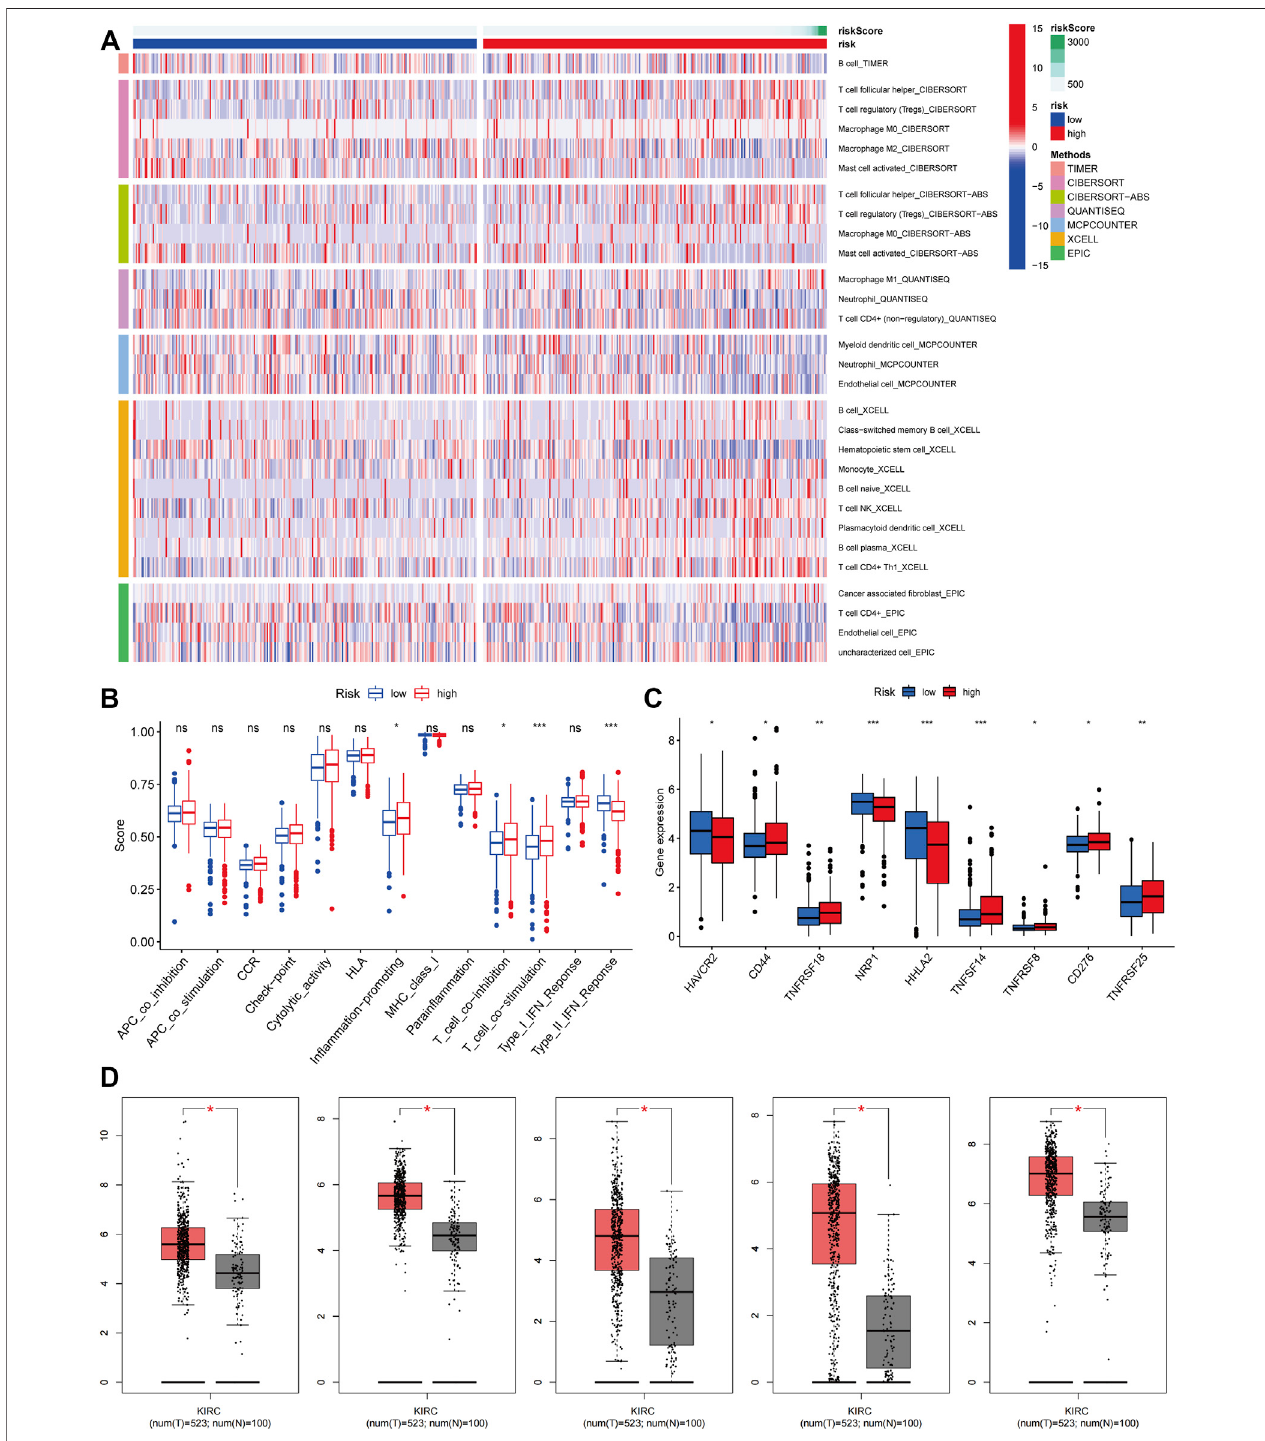
FIGURE 5 | Immune-cell Correlation and Immune Function Analysis. (A) Heatmap showed the expression of these immune cells in high and low-risk groups. (B) The analysis of immune function variability of ccRCC. (C) The immune checkpoint differential analysis of ccRCC. (D) The expression level of CD44, CD276, HAVCR2, HHLA2, and NRP1 from the GEPIA database ( p <